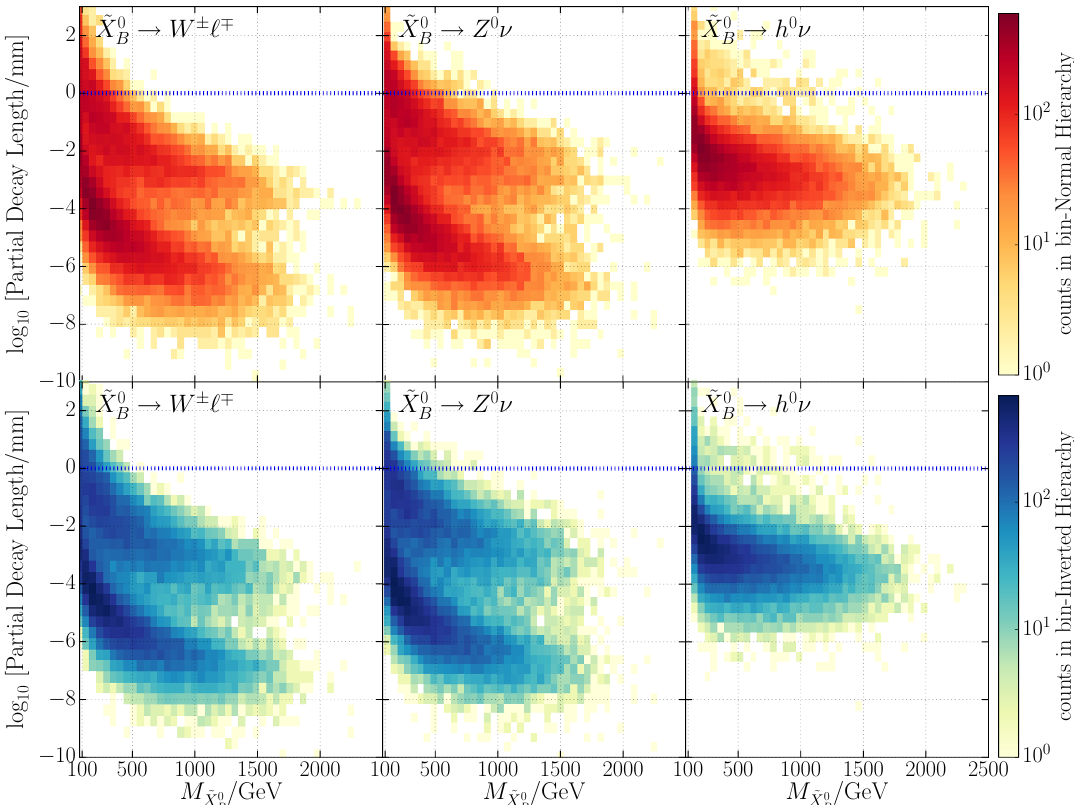
Figure 7. Bino neutralino LSP partial decay length in millimeters, shown for the individual decay channels, for both normal and inverted hierarchies. We have chosen (cid:18) 23 = 0 : 597 for the normal neutrino hierarchy and (cid:18) 23 = 0 : 529 for the inverted hierarchy. The choice of (cid:18) 23 has no impact on the decay length. The blue dashed line denotes a decay length of 1 mm, at and below which decays are \prompt". Note that on the x-axis 1) all (cid:12)gures begin at M on the left-hand side and 2) W (cid:6) there are no points above approximately 2300 GeV. This follows from the fact that, even though the maximum value we obtained for the Bino mass is 2792 GeV, points higher than 2300 GeV are statistically insigni(cid:12)cant. See (cid:12)gure